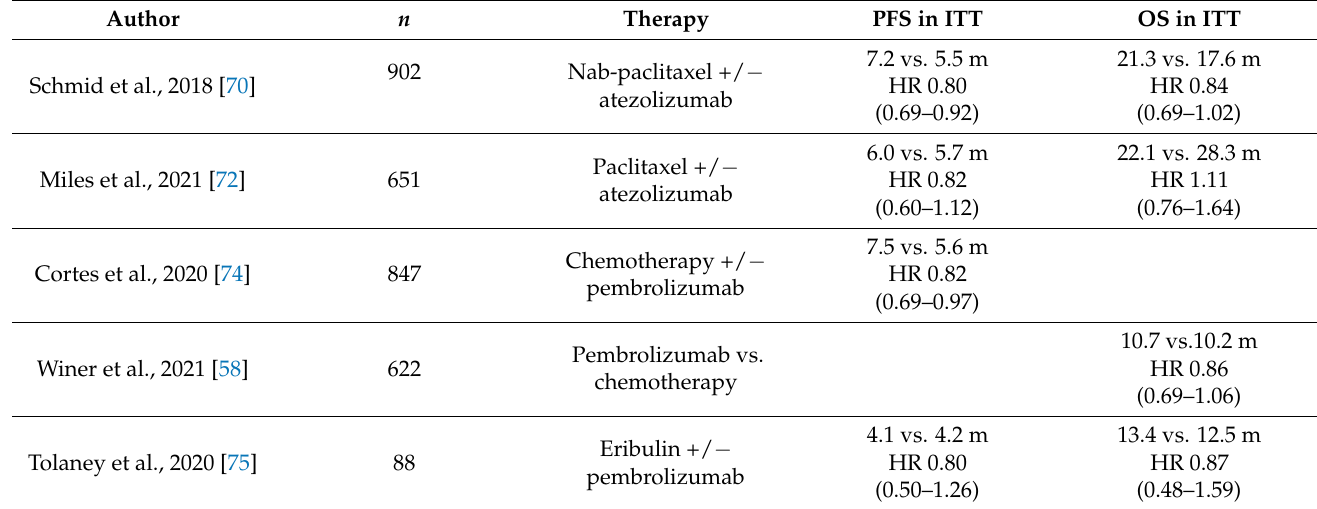
Table 3. Randomized evidence for ICPi in advanced breast